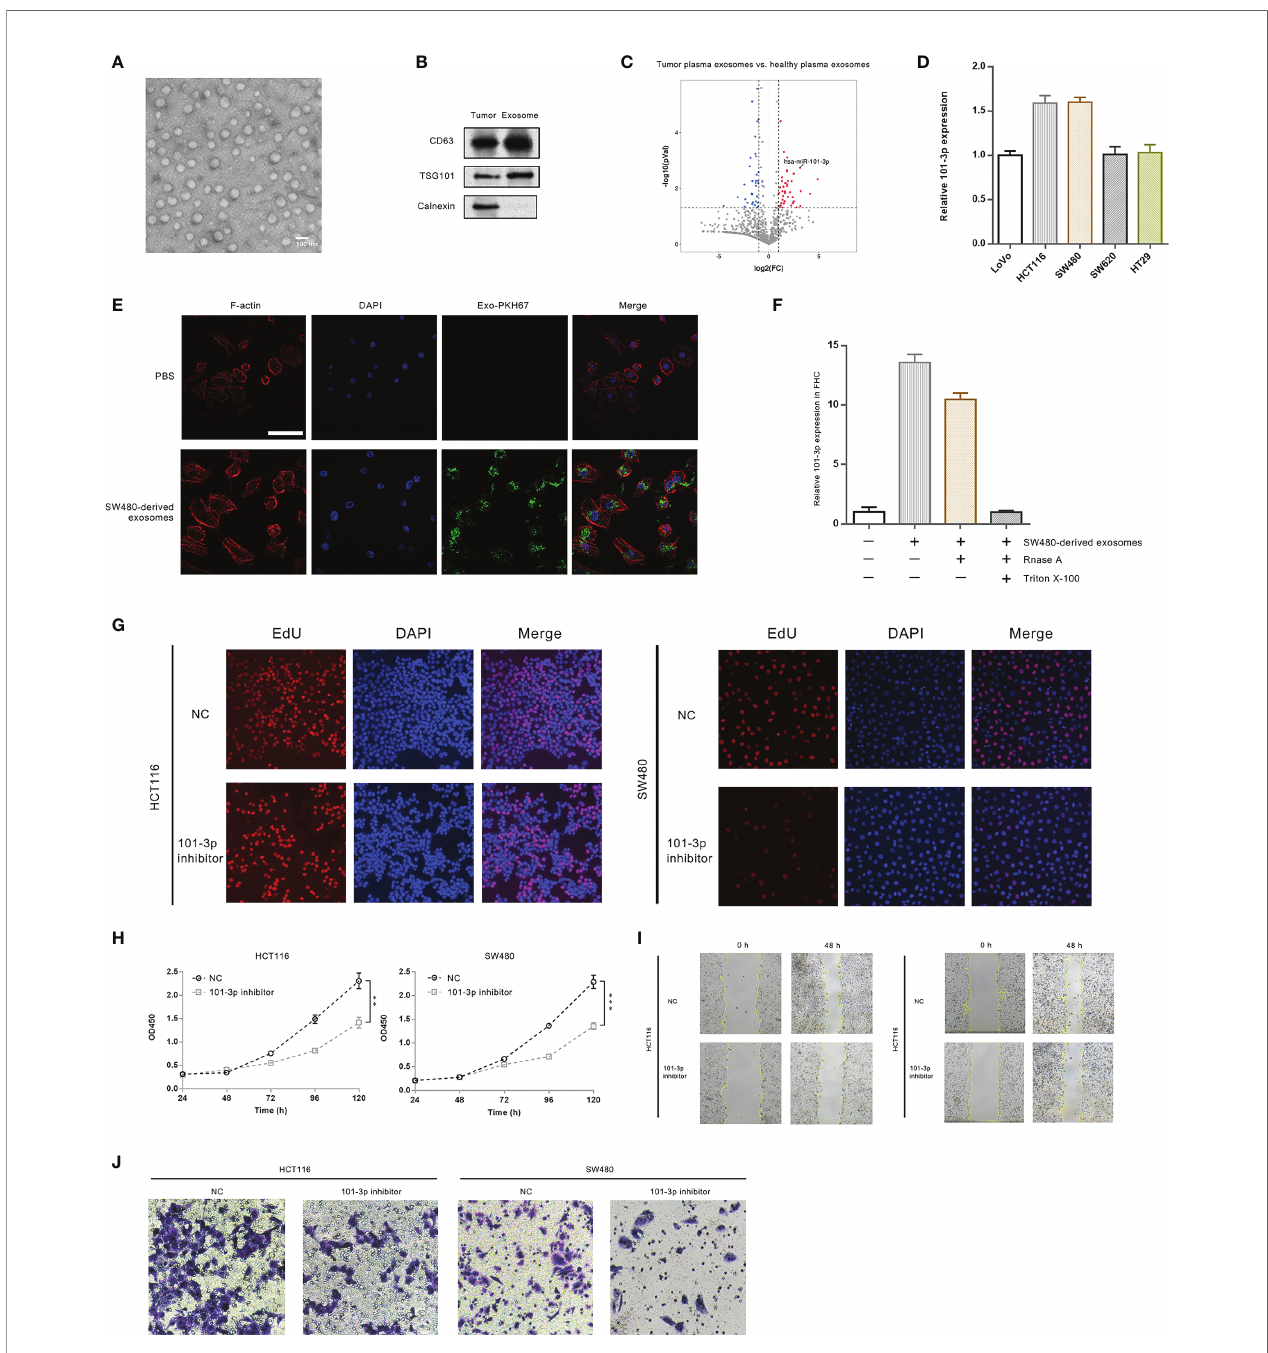
FIGURE 1 | 101-3p is highly up-regulated in CRC plasma exosomes and promotes oncogenesis. (A) Transmission electron micrograph of exosomes isolated from CRC patients. (B) Immunoblots of key proteins of isolated exosomes. (C) Volcano plots of miRNA sequencing results: plasma exosomes from CRC patients vs . plasma exosomes from healthy individuals. (D) Innate expression level of 101-3p in fi ve CRC cell lines. (E) Uptake of SW480-derived exosomes by FHC cell monitored by fl uorescence microscopy. (F) 101-3p level of FHC cells following uptake of SW480-derived exosomes. (G) Edu incorporation of HCT116 and SW480 cells stably expressing NC sequence or 101-3p inhibitor sequence. (H) Growth curves of HCT116 and SW480 cells stably expressing NC sequence or 101-3p inhibitor sequence monitored by CCK-8. (I) Wound healing assay of HCT116 and SW480 cells stably expressing NC sequence or 101-3p inhibitor sequence. (J) Transwell assay of HCT116 and SW480 cells stably expressing NC sequence or 101-3p inhibitor sequence. **, *** correspond to a p-value less than 0.01 and 0.001,